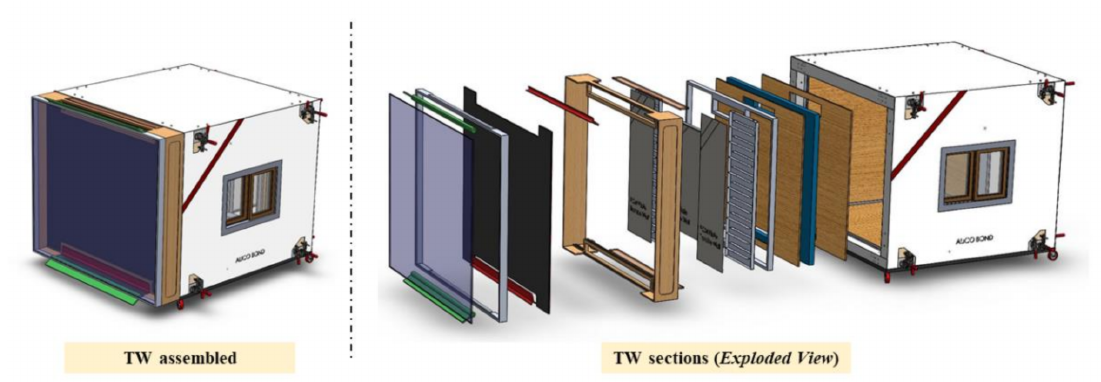
Figure 27. Modified Trombe wall sections mounted on the side wall of ThermoGreen ® .